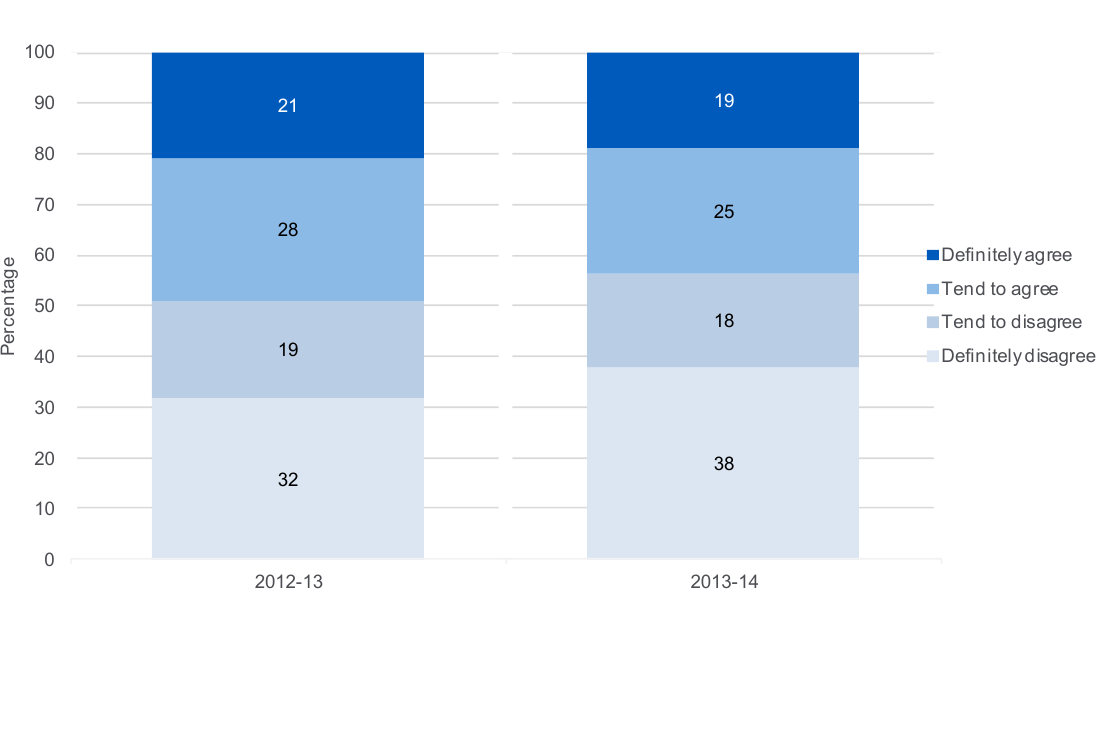
Figure 9: Extent to which people agree that they borrow things and exchange favours with their neighbours, 2012-13 to